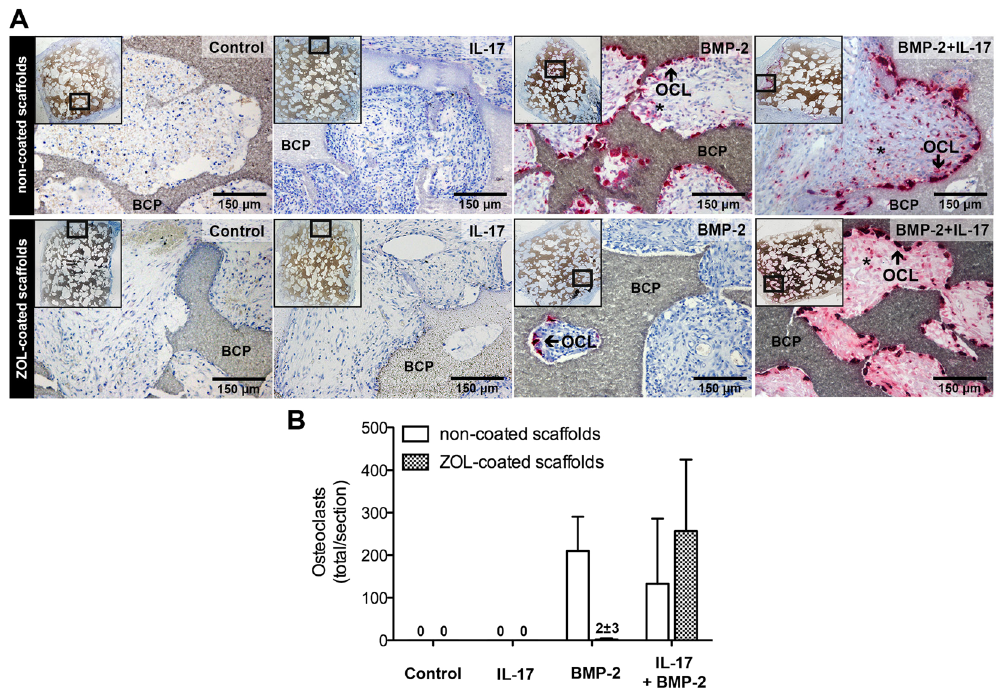
Figure 6. Role of osteoclasts during the early tissue response. ( A ) Tartrate-resistant acid phosphatase (TRAP) staining shows day-10 presence of osteoclasts (OCL, in red) and mononucleated TRAP-positive cells (indicated by asterisks). ZOL-coated and non-coated biphasic calcium phosphate (BCP) scaffolds were left untreated (control), or were loaded with IL-17 (100 ng/construct), BMP-2 (3 μ g/construct), or their combination. Representative images of each group are given, with the scaffold overview in insets. ( B ) Osteoclast counts are represented as the mean ± SD (n = 3). Mononucleated TRAP-positive cells were not included in the osteoclast